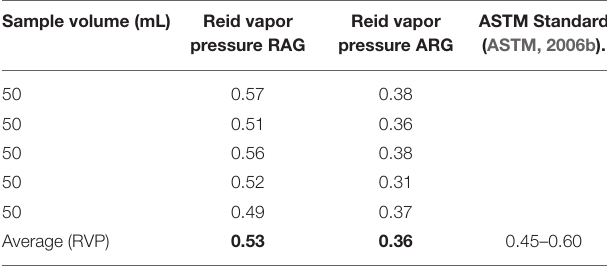
TABLE 4 | Reid vapor pressure (RVP) (kg/cm 2 ) at 37.8 ◦ C for RAG and LRG. Sample volume